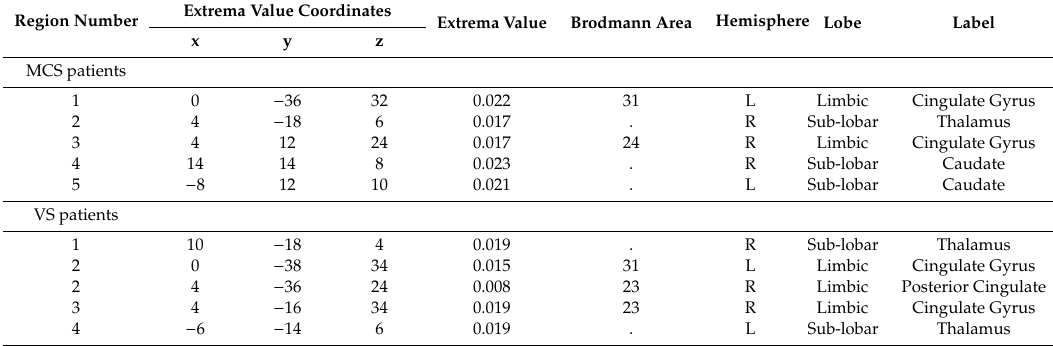
Table 4. Activity patterns during rs-fMRI in MCS and VS patients. Coordinates, extrema value and corresponding Brodmann area, lobe, hemisphere, and regional labels are reported for each region resulting from the ALE